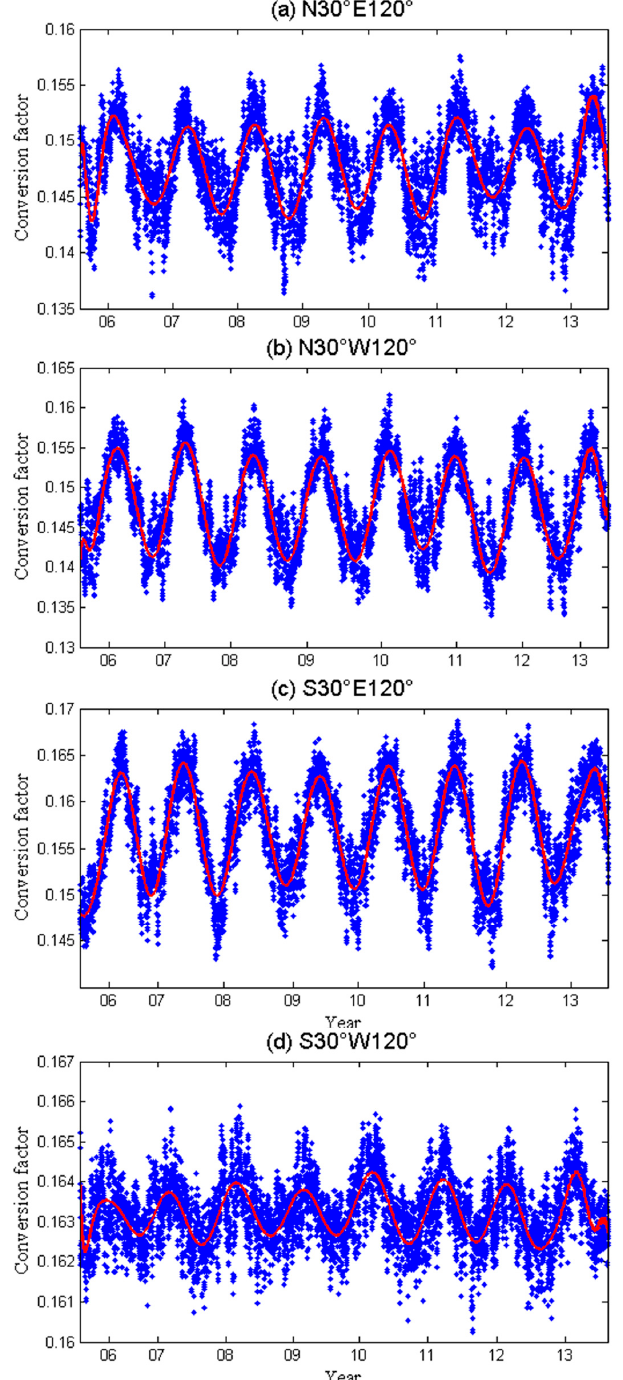
Figure 1. Changes of the conversion factors with time over the period from 2006 to 2013 at the four selected locations of ( a ) N30°E120°, ( b ) N30°W120°, ( c ) S30°E120° and ( d ) S30°W120°,